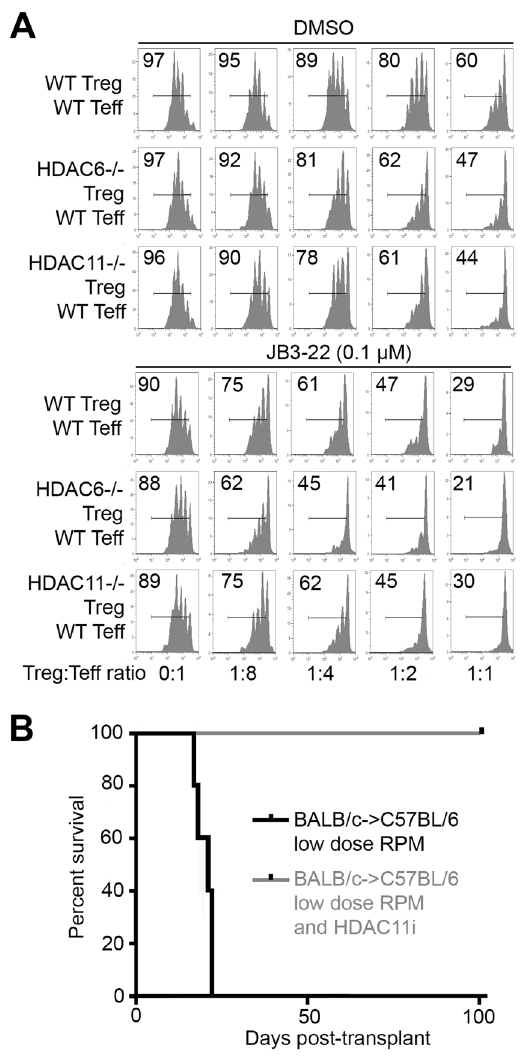
Figure 5. Effects of pharmacologic inhibition of HDAC11 on Treg function and allograft survival. ( A ) Testing of the in vitro effects of the HDAC11i, JB3-22, on WT, Hdac6 − / − and HDAC11 − / − Treg suppressive function. Upper 3 rows show baseline function of WT vs. HDAC6 − / − and HDAC11 − / − Tregs in the presence of DMSO carrier alone; proliferation of CFSE-labeled conventional T cells is shown in each panel. The lower 3 rows show the effects of HDAC11i (0.1 µ M) on Treg function using the same cell types as tested above. The point is that HDAC11i further increases the suppressive function of WT and HDAC6 − / − Tregs, but does not have any additional effects on the suppressive function of HDAC11 − / − Treg cells. Data are representative of 3 separate assays. ( B ) Effects of HDAC11i (JB3-22, (10 mg/kg/d, 14 d, i.p.) plus low-dose RPM (0.2 mg/kg/d, 14 d) in the BALB/c- > C57BL/6 cardiac allograft model. Control mice receiving low dose RPM rejected their allografts within 2–3 weeks, but cardiac allografts were maintained long-term ( > 100 days, p < 0.01) in recipients treated for 2 weeks with low dose RPM plus HDAC11i therapy; 6